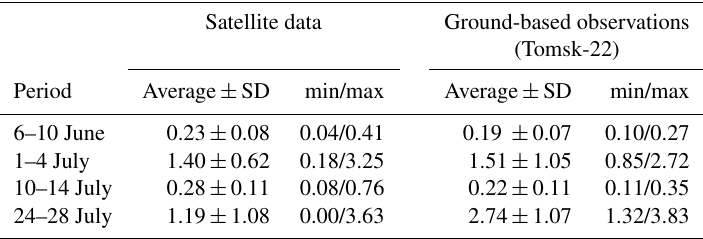
Table 2. Average ( ± SD), minimal, and maximal values of AOD (550nm) in different periods of 2012 Siberian fires according to data from ground-based and satellite measurements over the central part of Western Siberia.